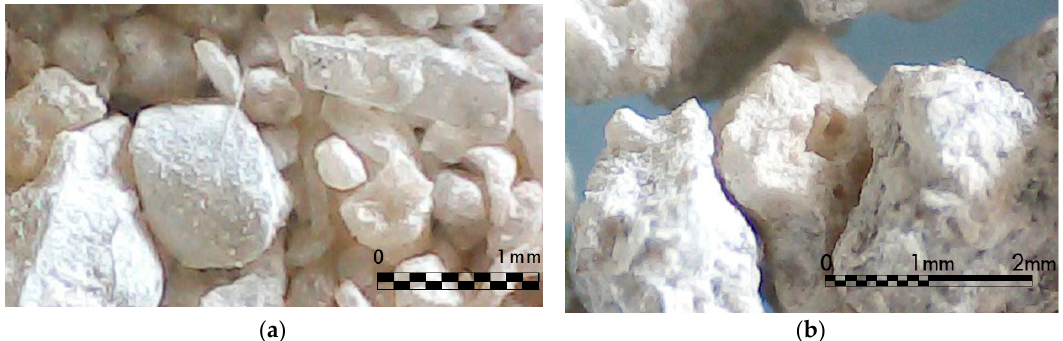
Figure 2. Micrographs of samples of granulated blast furnace slag.